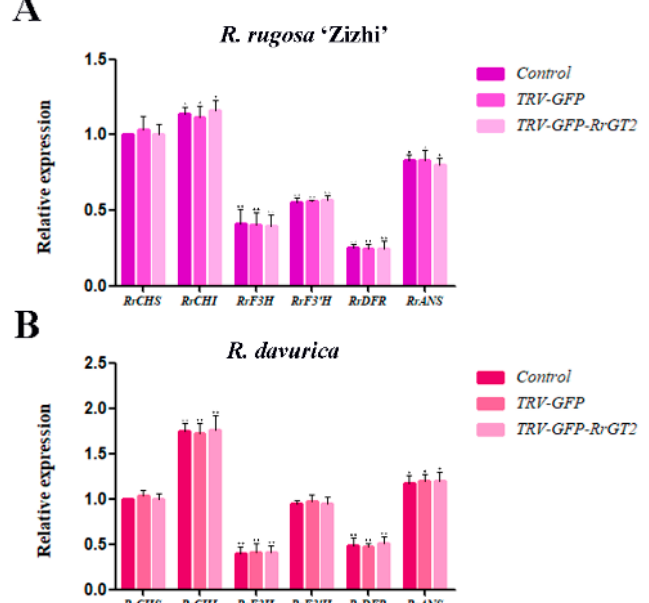
Figure 7. Relative expression levels of six key structural genes ( RrCHS , RrCHI , RrF3H , RrF3’H , RrDFR and RrANS ) upstream of RrGT2 in the anthocyanin pathway of R. rugosa ‘Zizhi’ ( A ) and R. davurica ( B ) at the full opening stage. RrGAPDH was used as the internal control. The error bars represent the SDs of triplicate reactions. The experiment was repeated three times and each yielded